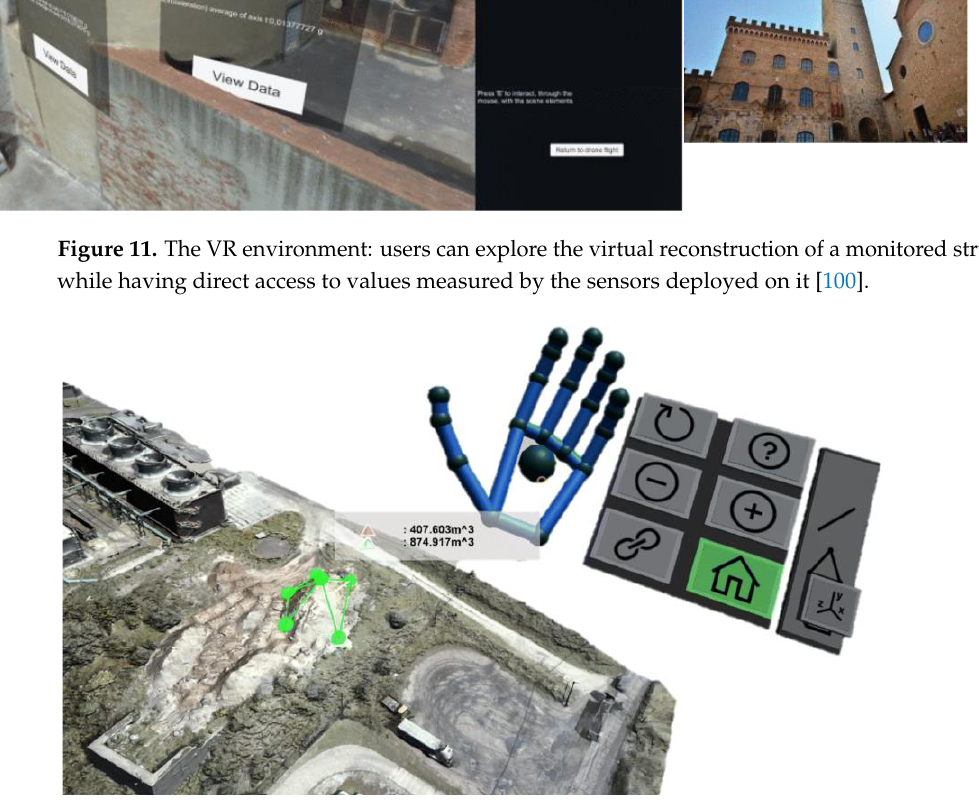
Figure 11. The VR environment: users can explore the virtual reconstruction of a monitored struc- ture while having direct access to values measured by the sensors deployed on it [100].